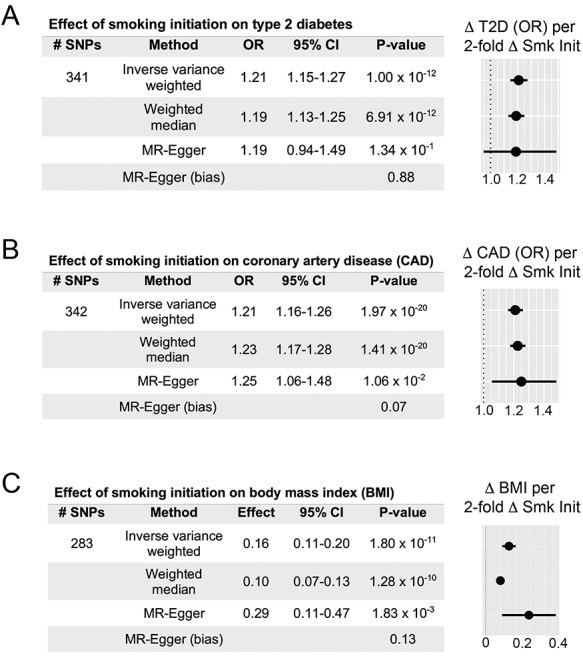
Two-sample Mendelian randomization determines that smoking initiation (Smk Init) increases type 2 diabetes (T2D) risk, CAD risk and BMI. (A) Genetically determined smoking initiation risk increases T2D risk. Two-sample Mendelian randomization OR estimates, 95% confidence intervals and forest plot represent changes associated with 2-fold increase in genetic smoking initiation ‘risk’. MR-Egger intercept, a bias measurement, does not deviate significantly from zero. This validates effect estimates. (B) Increased smoking initiation risk elevates CAD risk. OR estimates, 95% confidence intervals and forest plot represent changes associated with 2-fold increase in smoking initiation exposure. MR-Egger intercept does not deviate significantly from zero, validating the effect estimate. (C) Increased smoking initiation risk increases BMI. Effect estimates, 95% confidence intervals and forest plot represent changes in BMI (standard deviation units) associated with 2-fold increase in smoking initiation exposure. MR-Egger intercept does not deviate significantly from zero, validating the effect estimate.